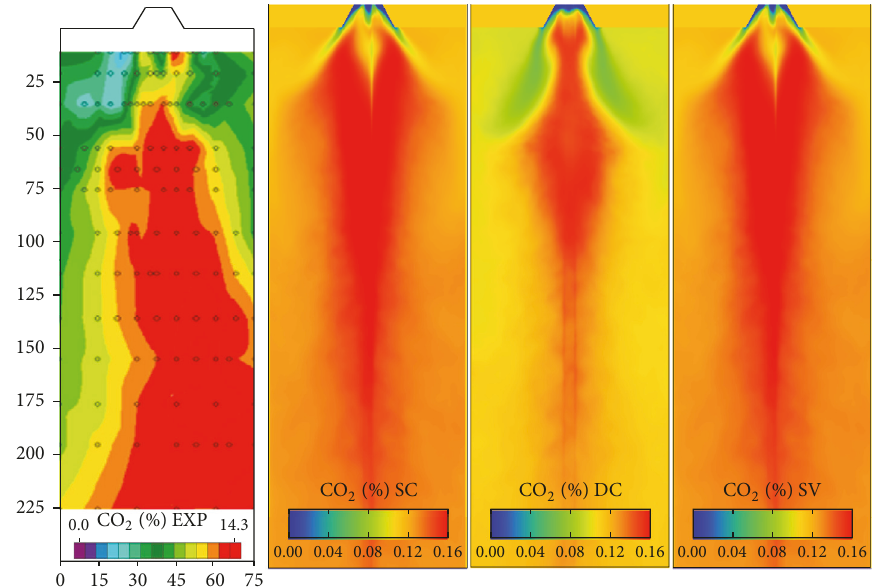
Figure 10: Experimental (adapted from [5]) and numerical maps of CO 2 concentration. Dimensions on the the left are given in centimetres.